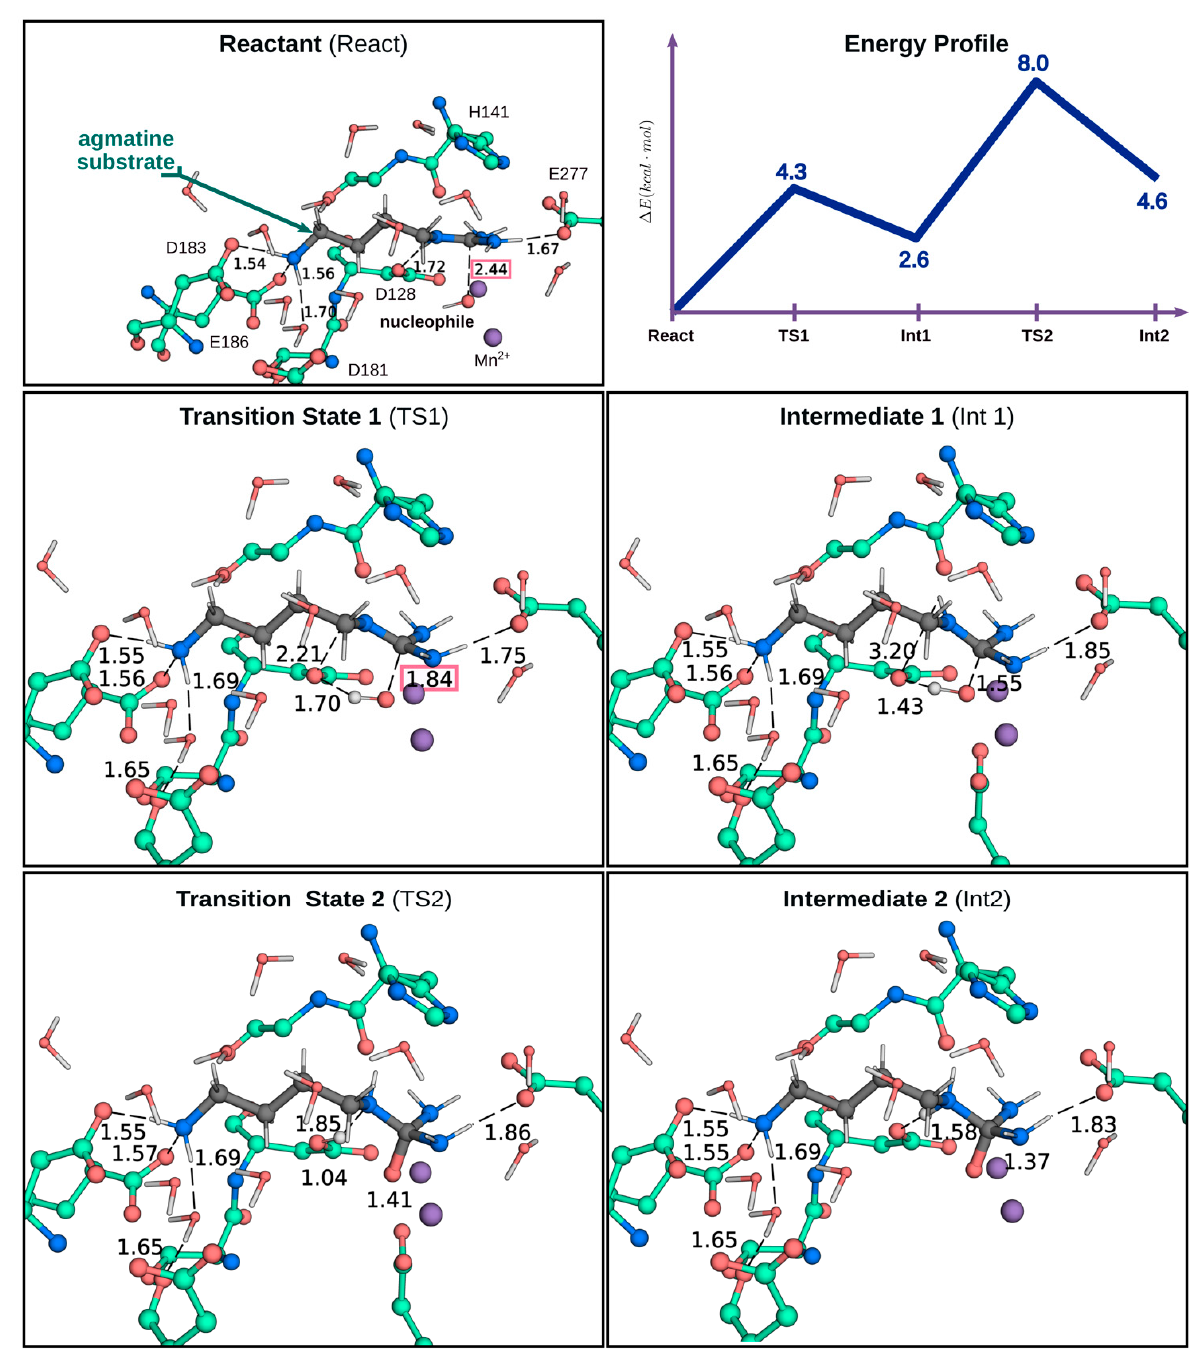
Figure 6. Representative structures and potential energy profile of the reaction path. Schematically describes the hydrolysis of agmatine by the Chimera A2 to the formation of the tetrahedral intermediate (Int2) that forms prior to the release of putrescine.